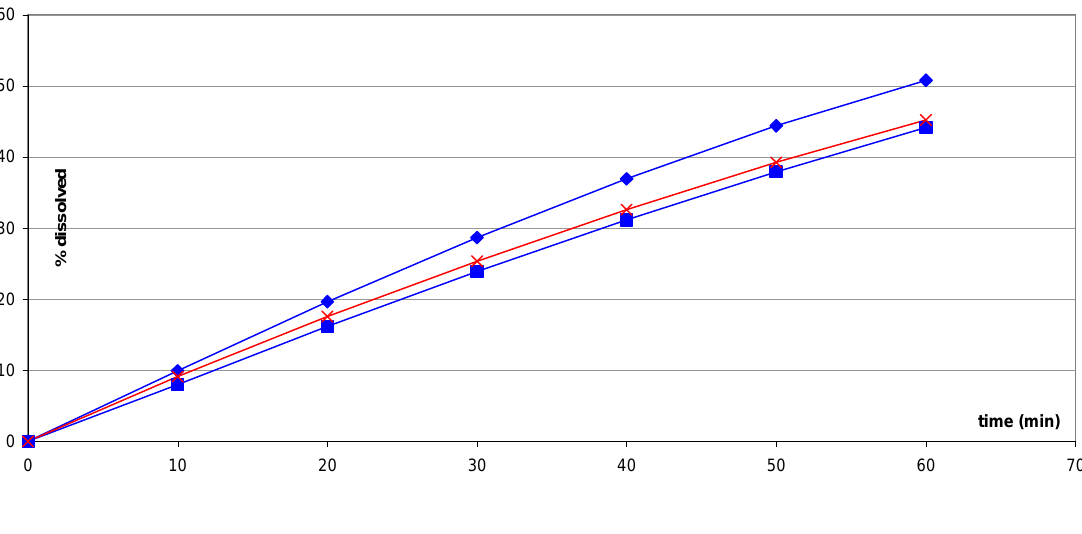
Figure 3. Dissolution profiles for salicylic acid tablets with small vessel accessories versus USP method with one liter